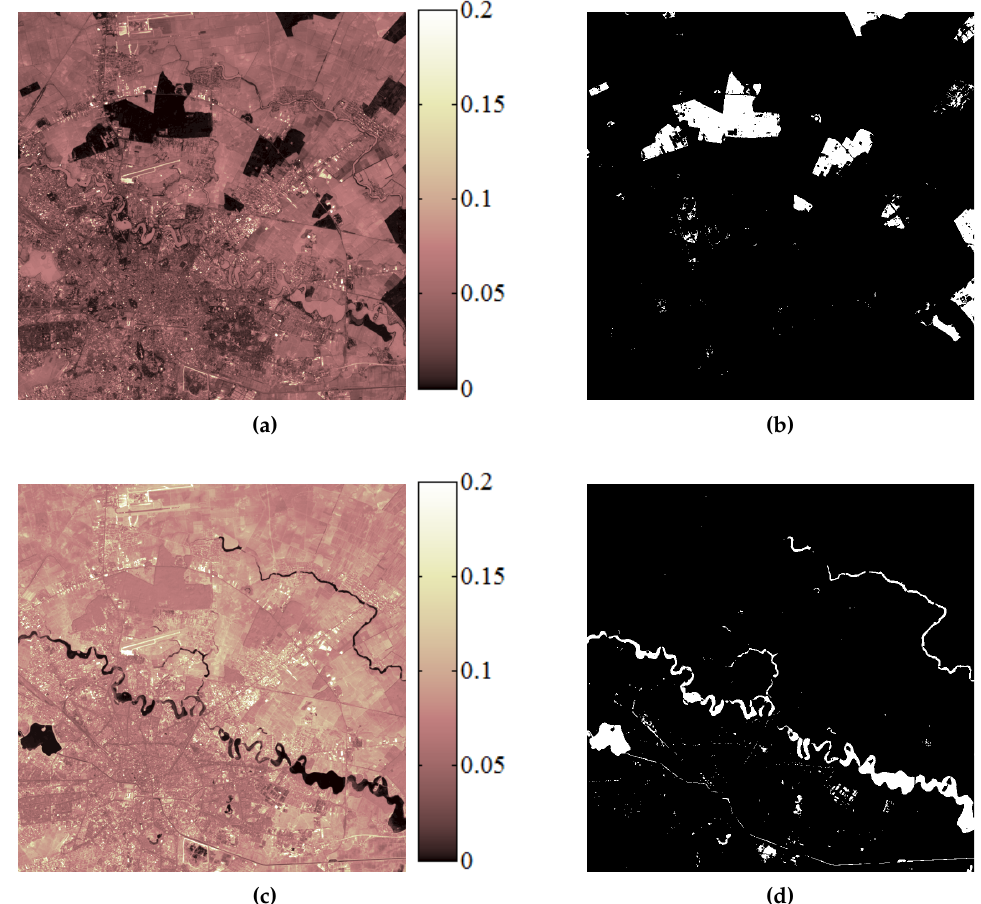
Figure 11. Land cover mapping in long Landsat SITS. ( a ) DTW distance image for a query made inside the forestry area. ( b ) Forestry area delimitation using the proposed query-by-example retrieval method. ( c ) DTW distance image for a query made in an area covered by water. ( d ) Water delimitation using the proposed query-by-example retrieval method. In the case of DTW distance images presented in ( a , c ), dark color represents similar evolutions and bright color represents non-similar evolutions, whereas in ( b , d ), white pixels correspond to spatio-temporal patterns that are similar to the query, which was selected from the region of